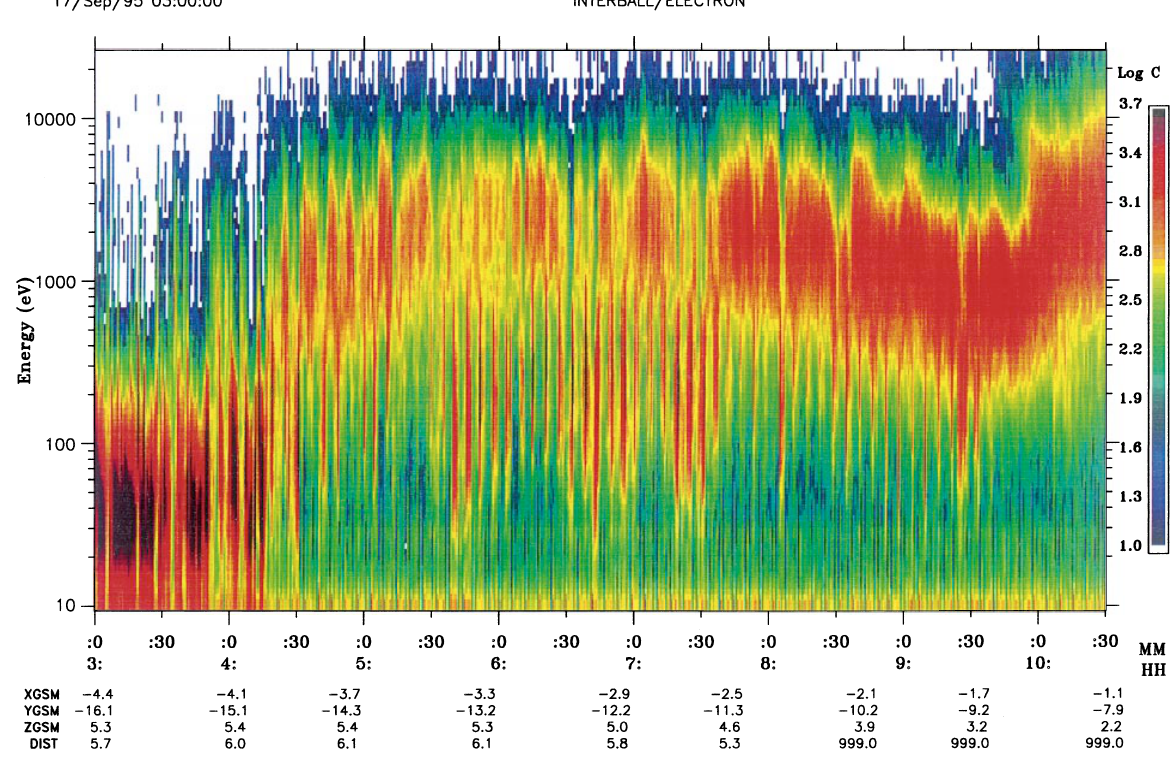
Fig. 4. Same as Fig. 3 for 17 September 1995, between 03:00:00 and 10:00:00 UT